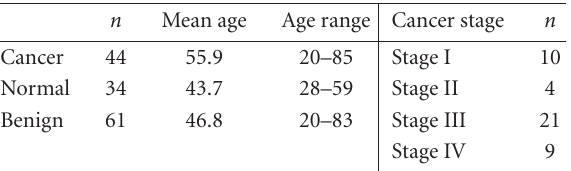
Table 1. Demographics of the cancer and control groups in- cluded in the study.